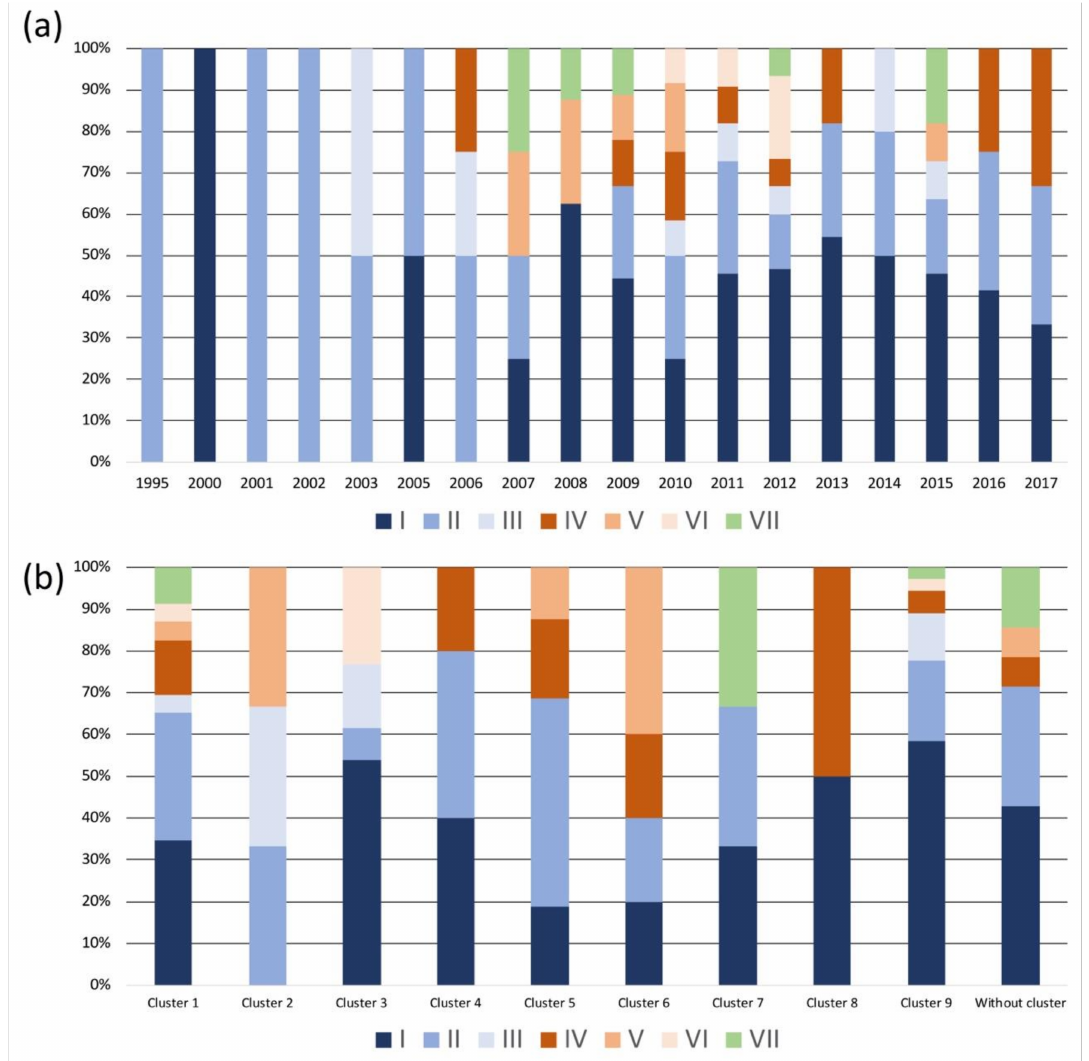
Figure 6. Temporal distribution of the seven main types ( a ) and content of each of them in the nine clusters analysed ( b